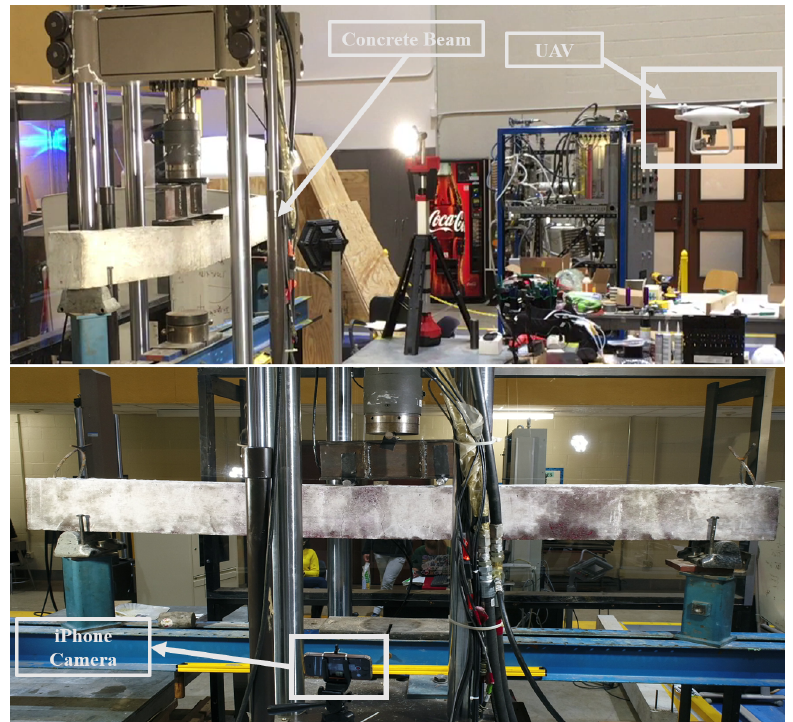
Figure 6. Experimental Setup showing (above) simply supported concrete beam transversely loaded at two points at its center and the video of the experiment being acquired using UAV, (below) and a still ground-based iPhone camera on a tripod is used to record the same experiment.